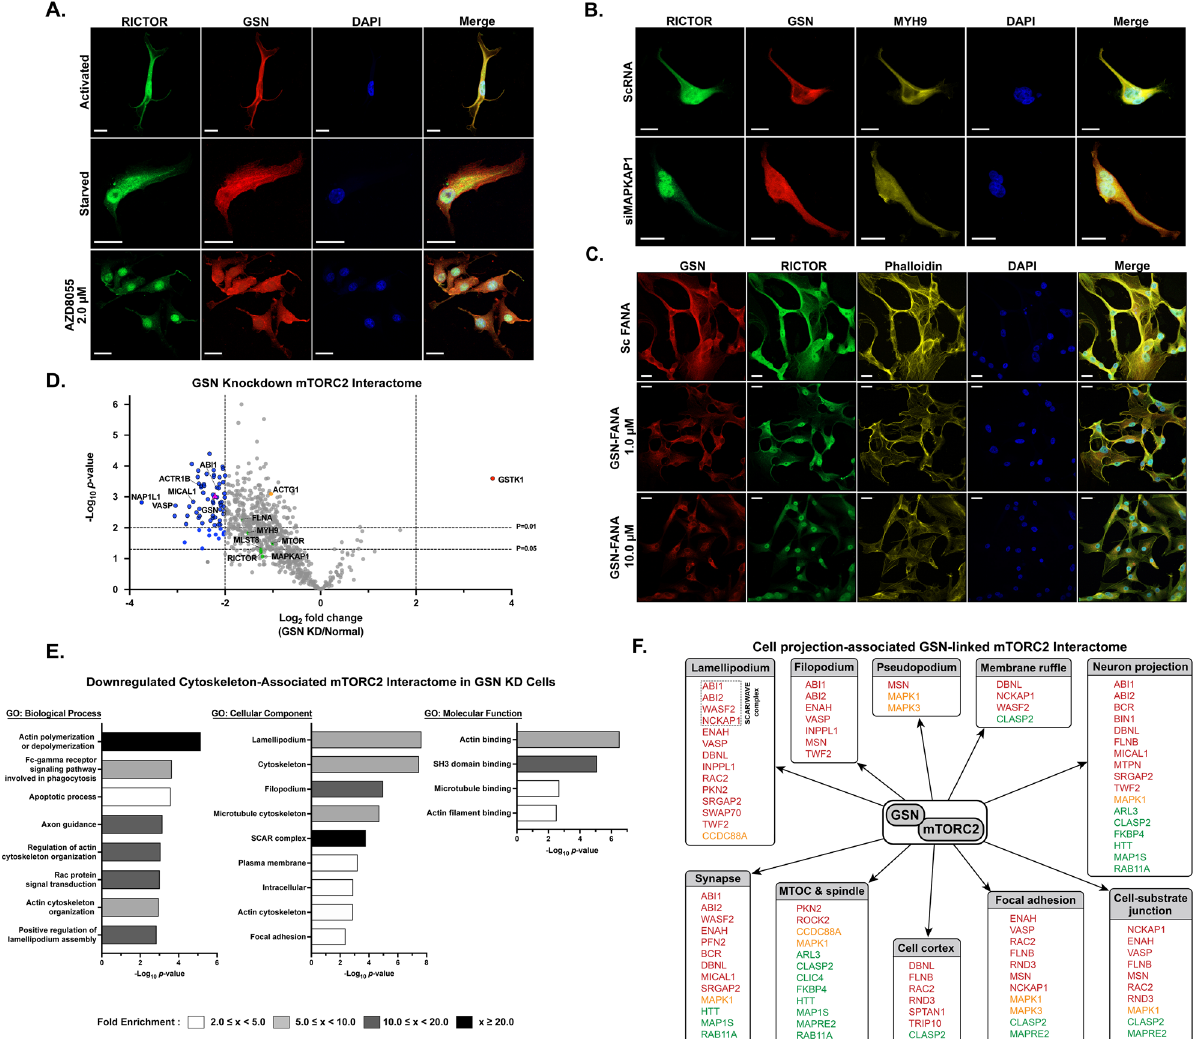
Figure 6. Significance of GSN in mTORC2-mediated cell migrational control. (A) Immunofluorescence staining of U87MG cells showing localization of RICTOR and GSN under activation, serum starvation, and inhibition conditions. Scale bar = 20 µM. (B) Immunofluorescence staining of U87MG cells showing colocalization of RICTOR, GSN, and MYH9 under control and MAPKAP1 knockdown conditions. (Sc: scrambled siRNA). Scale bar = 20 µm. (C) Immunofluorescence staining showing localization of GSN and RICTOR and F-actin arrangement in U87MG cells after GSN knockdown (1.0 µM and 10.0 µM of GSN-FANA) compared to scrambled FANA control. Scale bar = 20 µm. (D) Volcano plot of the results of AP-MS experiments showing changes in mTORC2-interacting proteins; n = 3 biological replicates. Proteins with log 2 fold change (LFQ GSN KD/normal) ≥ 2, p < 0.05 are highlighted in red, while proteins with log 2 fold change ≤ -2, p < 0.05 are highlighted in blue. Proteins with p -values < 0.01 are shown with a black border. Statistical significance was calculated from the LFQ values of each common protein of the two conditions using an unpaired two-sided Student’s t-test. Key mTORC2-interacting proteins are shown in green circles. GSN is shown in a purple triangle. (E) Gene ontology analysis of decreased/absent proteins in the mTORC2 interactome of the GSN knockdown group. Plots showing top-ranked -log 10 ( p -value) GOBP, GOCC, and GOMF terms with FDR < 0.10 and the bar colors representing fold enrichment of each specific term. (F) Diagram showing the GSN-linked mTORC2 interactome associated with cell projection structures. (red: MF-associated proteins, green: MT-associated proteins, yellow: MF-MT-associated